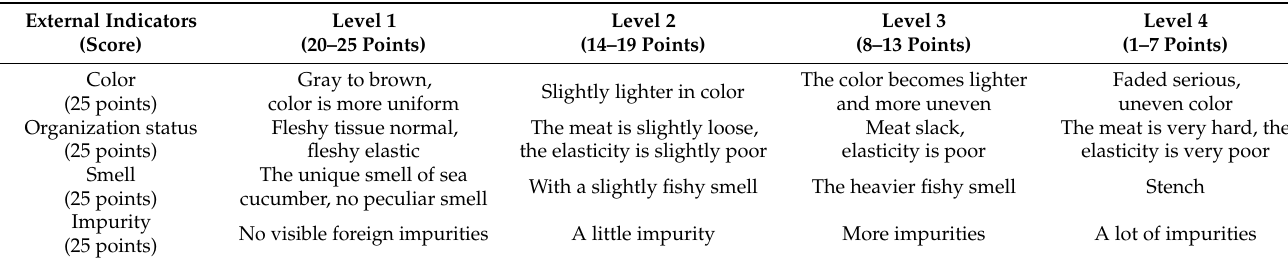
Table 1. Sensory score evaluation of stored and boiled sea